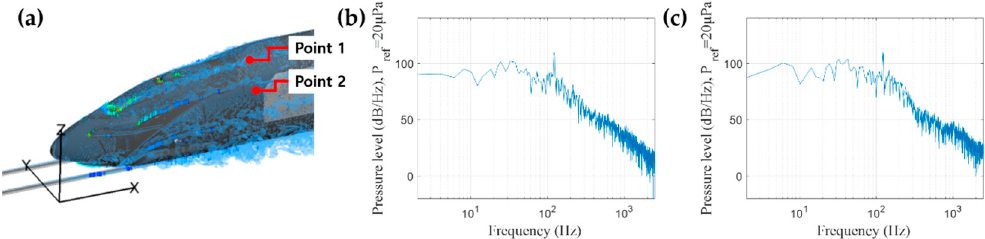
Figure 17. Pressure spectrum at Point 1 and Point 2: ( a ) locations of Point 1 and Point 2; ( b ) pressure spectrum at Point 1; ( c ) pressure spectrum at Point 2.